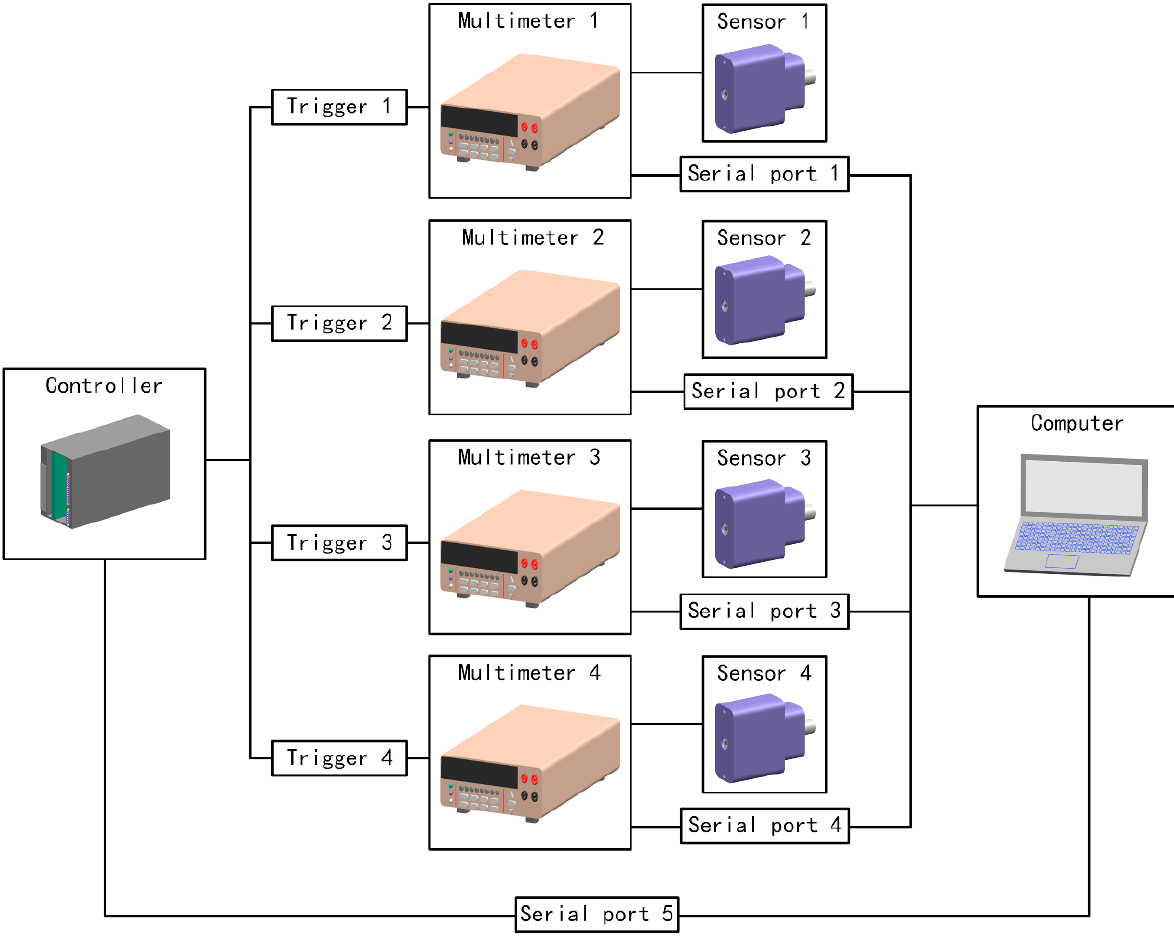
Figure 11. The drawing of experimental data acquisition system.